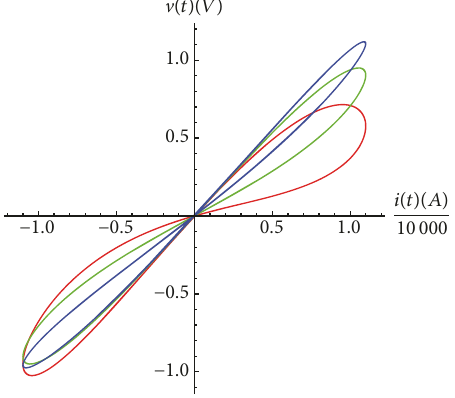
𝑖(𝑡) . Similarly to the voltage-current curve, the loop area